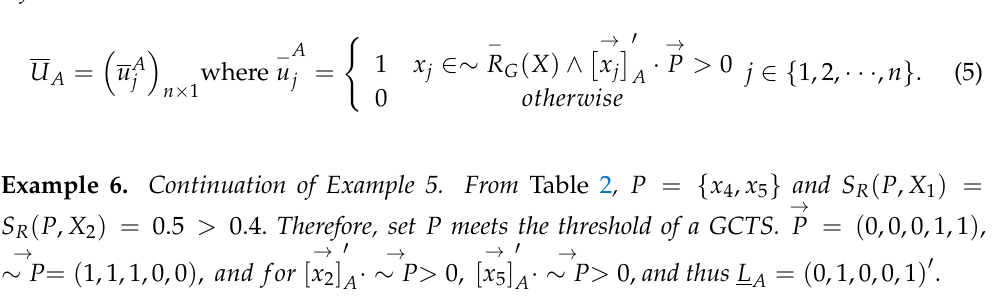
Table 2. An example of multi-label table with an extra target concept. U a 1 a 2 a 3 X 1 X 2 P x 1 1 M x 2 M 0